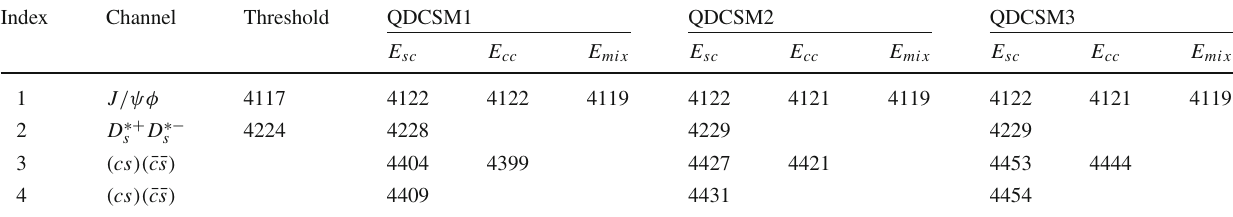
Table 7 The lowest-lying eigenenergies (in MeV) of c ¯ cs ¯ s tetraquarks with J PC = 2